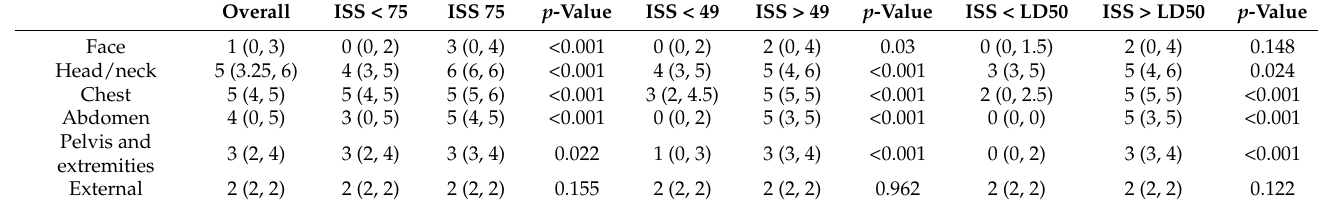
submaximal ( a ) and potentially survivable ( b , c ) trauma. *** p < 0.001, ** p < 0.01, ns: not significant.